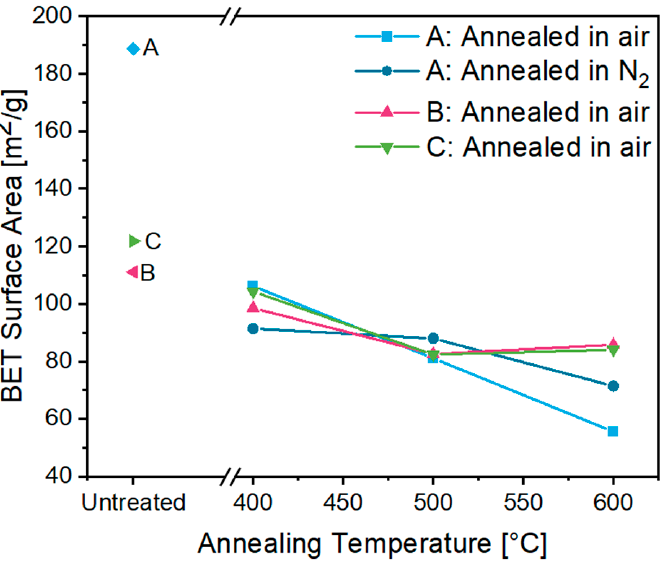
Figure 11. Nitrogen sorption isotherms of ITO aerogels A ( a ), B ( b ) and C ( c ) before and after annealing at temperatures of 400–600 °C in air (see Figure S11 for the corresponding BET plots). The BET surface area of the untreated aerogel A amounts to 188.6 m 2 /g, which is re-